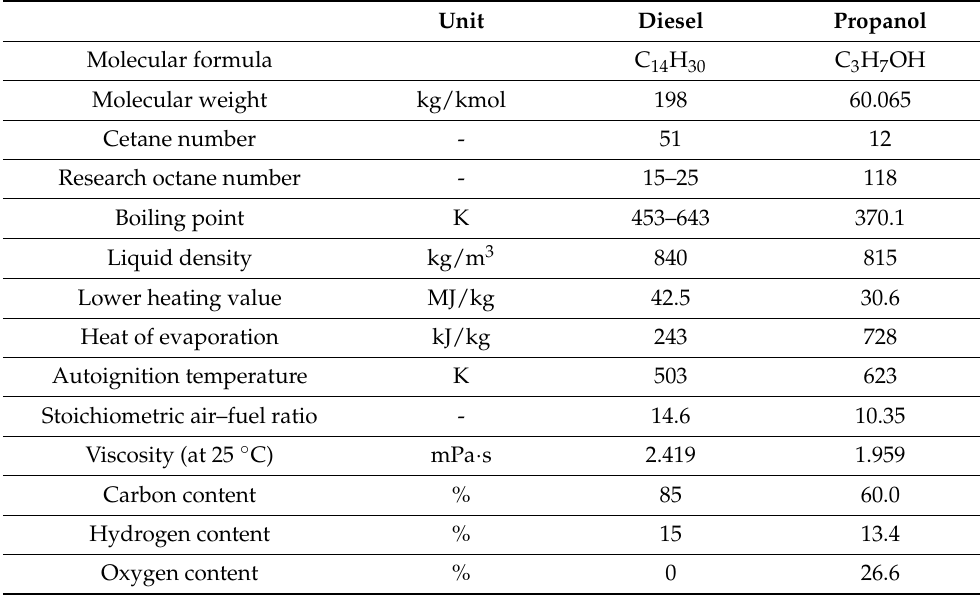
Table 3. Fuel specifications